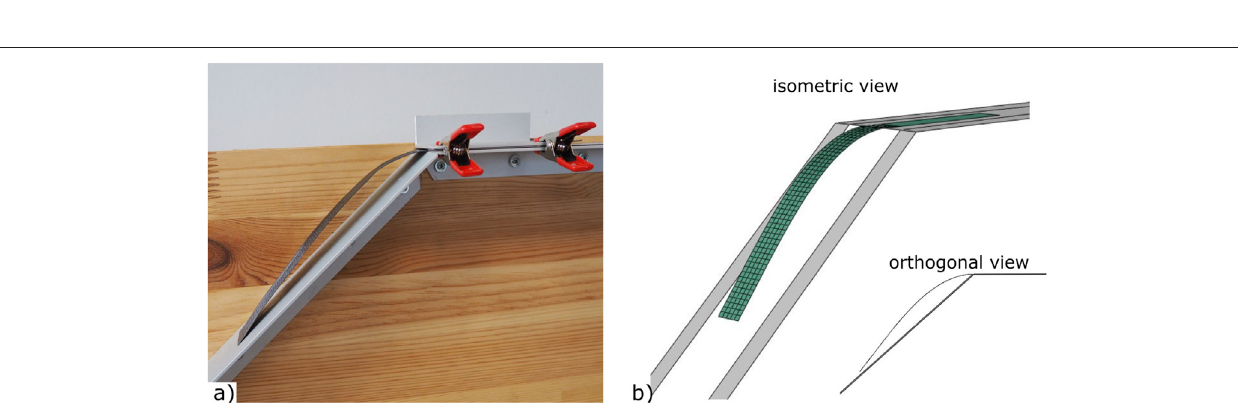
FIGURE 2 | (A) Modi fi ed free-fall cantilever beam bending test and (B) representative FE results of the calibrated model.